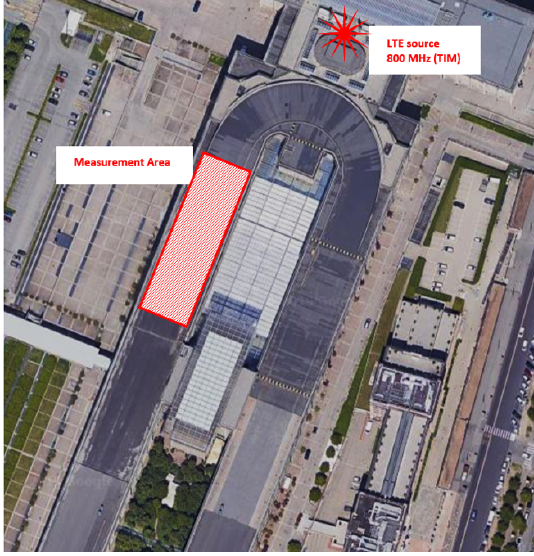
Figure 1. The measurement site (sample site) seen from above (photo copyright: Agricultural disbursement agency).